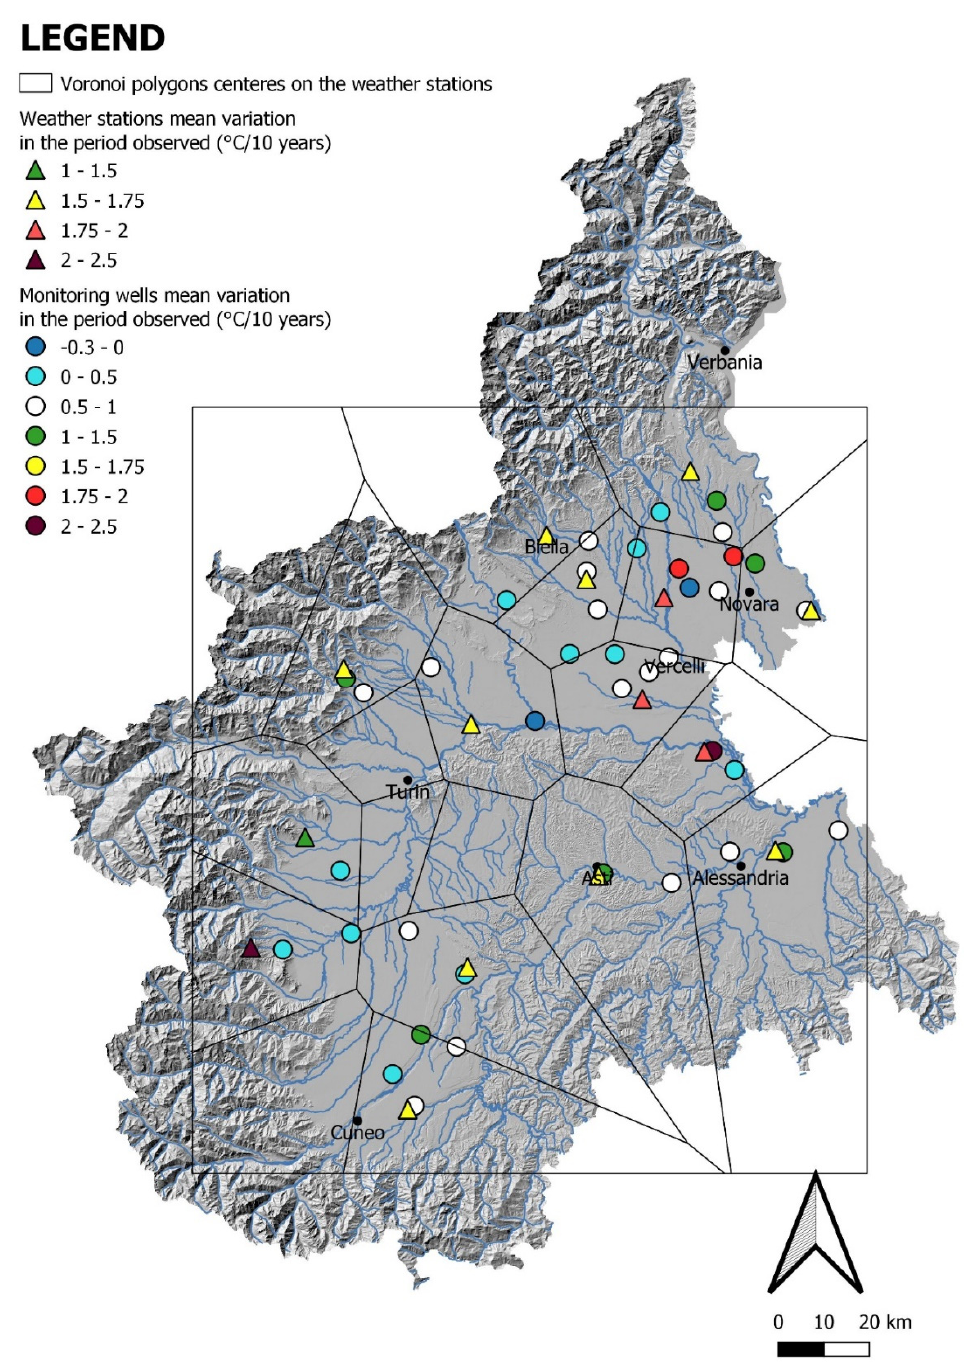
Figure 5. Mean variation of ATs (triangles) and GWTs (rounds) in the entire observed period (2010–2019) and Voronoi polygons, centered on weather station used to match the monitoring wells to the weather stations.